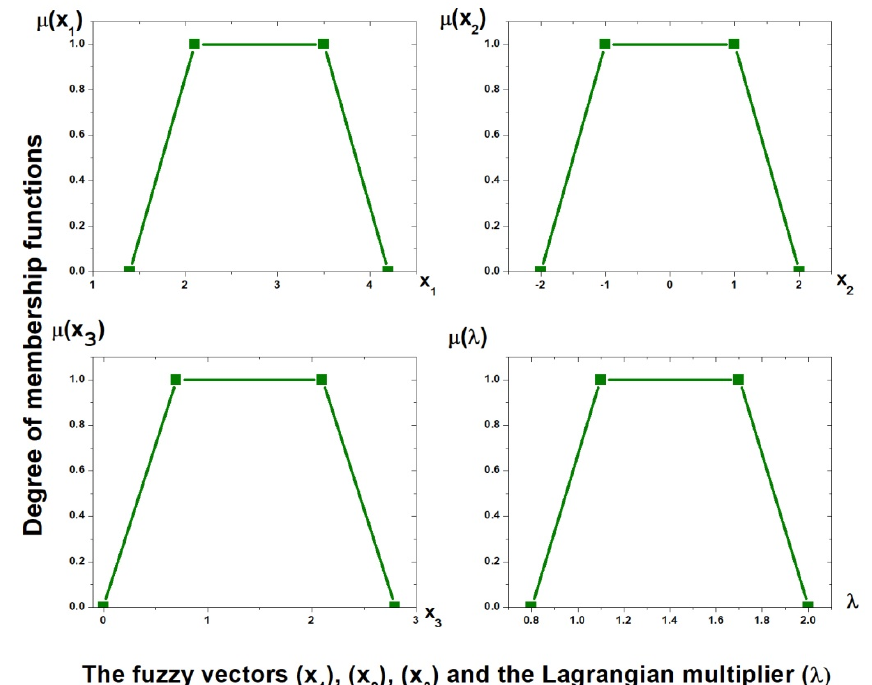
Figure 2. Pictorial representation of the fuzzy vectors and Lagrangian multiplier. Hence the optimum result of the NLPP is (cid:16) (cid:17) ( k ) = [ 1.4, 2.1, 3.5, 4.2 ] , x 1 (cid:16) (cid:17) = [ 0.8, 1.1, 1.7, 2 ] & λ ( k )